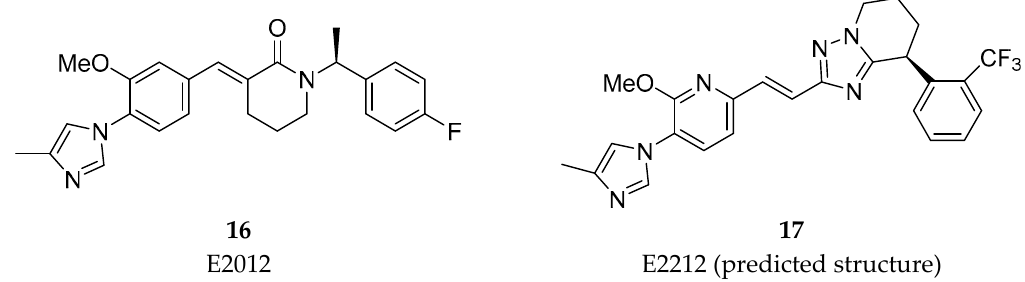
Figure 14. Structures of E2012 ( 16 ) and E2212 ( 17 , predicted structure).